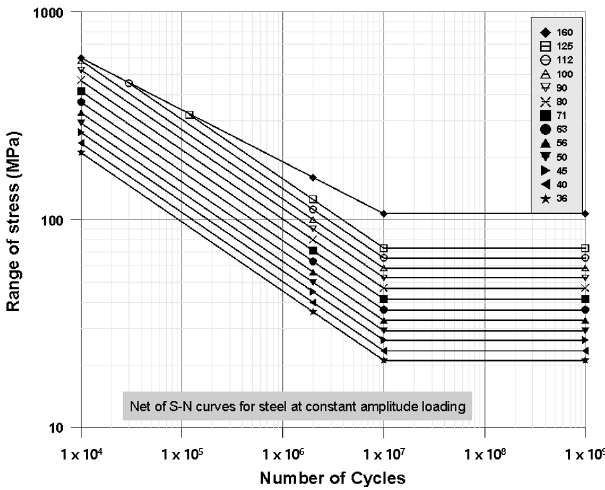
Figure 4. Fatigue resistance S-N curve proposed by IIW. The data was from Ref. [12].